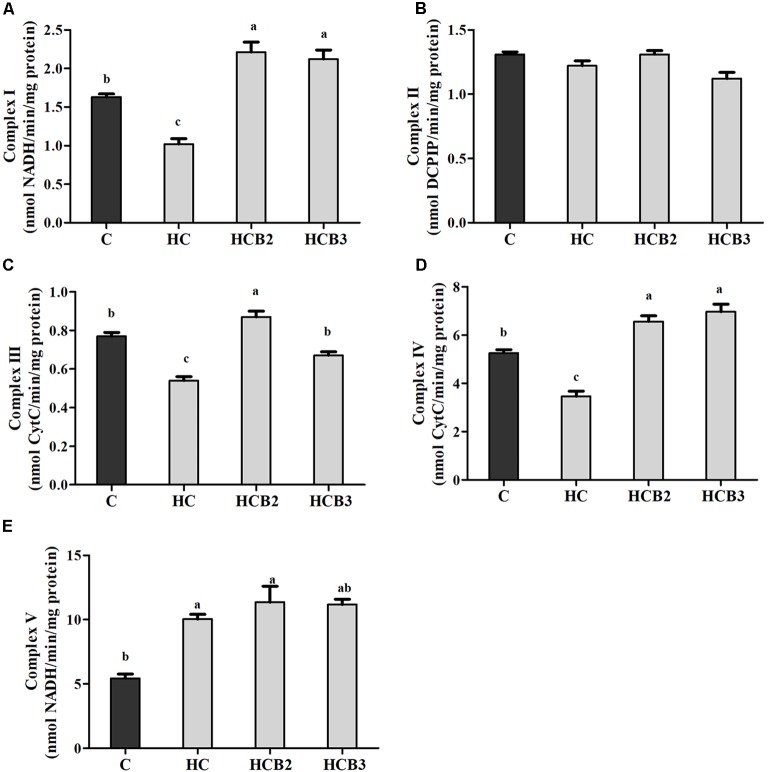
The activities of mitochondrial respiratory chain complexes (Complex I (A), II (B), III (C), IV (D) and V (E)) in the liver of blunt snout bream fed different experimental diets. Each data represent the means ± SEM of four replicates. Bars assigned with different superscripts are significantly different (P < 0.05). Complex I: NADH–ubiquinone oxidoreductase; Complex II: Succinate–ubiquinone oxidoreductase; Complex III: Ubiquinone–ferricytochrome-c oxidoreductase; Complex IV: Cytochrome c oxidase; Complex V: F1F0–ATP synthase. They were expressed as nanomolars per minute per milligram protein.